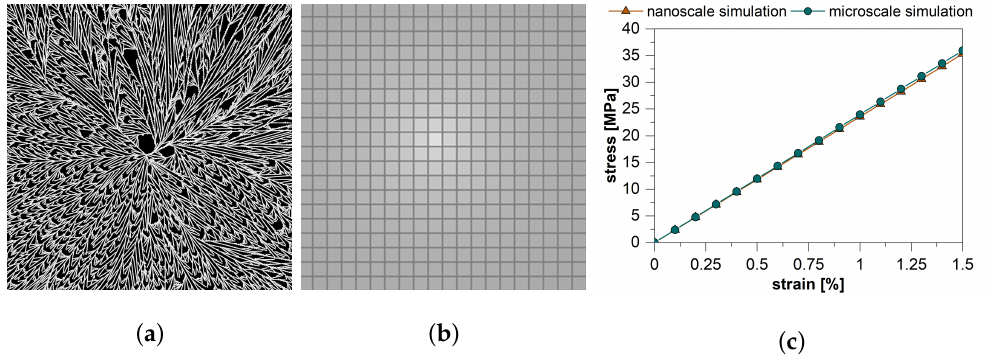
Figure 12. ( a ) Used section of a spherulite in the nanoscale simulation. Depicted is the crystalline fraction. ( b ) Division of the section of the spherulite in the microscale simulation. In the microscale simulation, the lamellar structure is no longer available, only the degree of crystallization and the distance as well as the direction to the nucleus of the spherulite are present on the individual cells. Depicted is the degree of crystallization, the cell edges are marked. ( c ) Calculated material response from the nanoscale simulation compared with the material response from the microscale simulation using the material parameter